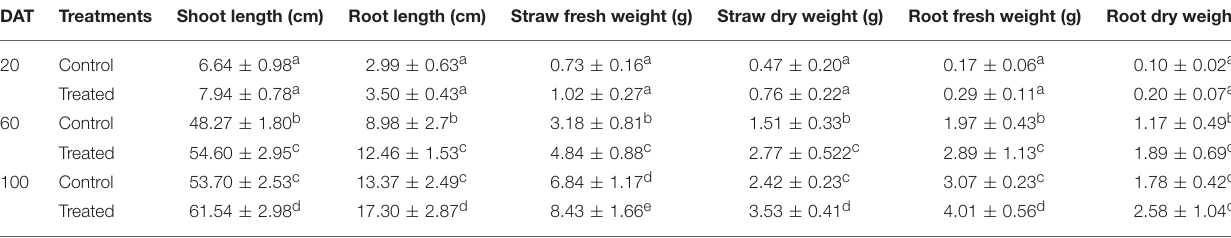
TABLE 4 | Effect of MSSRFD41 priming on growth of finger millet seedling in pots. DAT Treatments Shoot length (cm) Root length (cm) Straw fresh weight (g) Straw dry weight (g) Root fresh weight (g) Root dry weight (g)